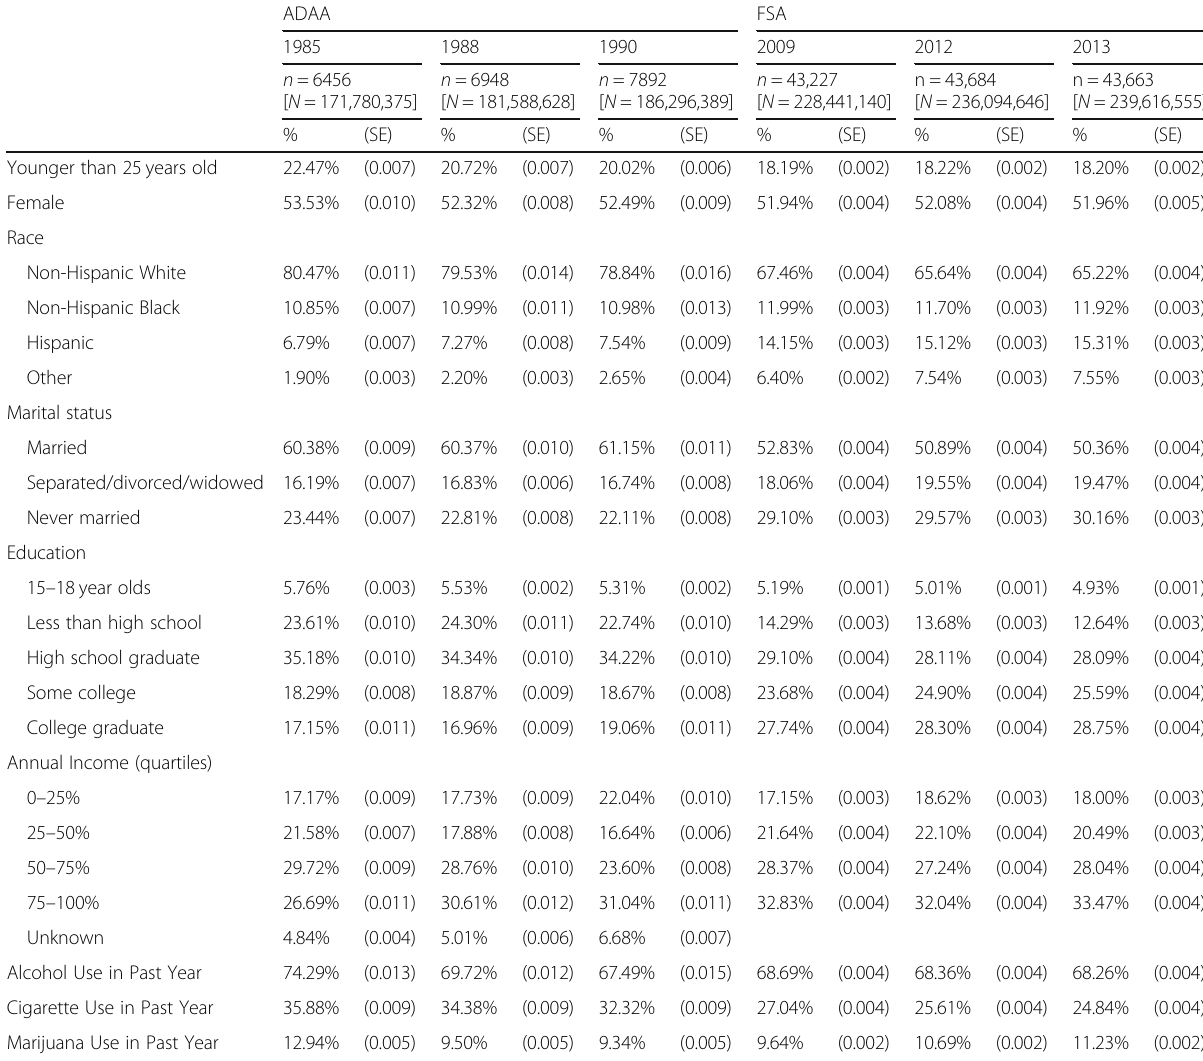
Table 1 Sociodemographic characteristics of survey participants during ADAA and FSA